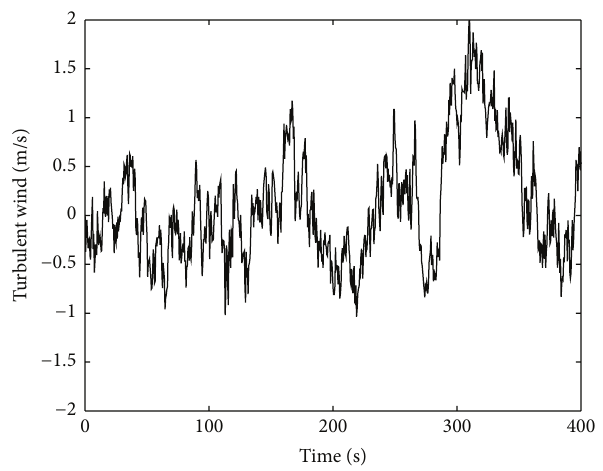
Figure 5: Turbulent wind in 400 seconds.